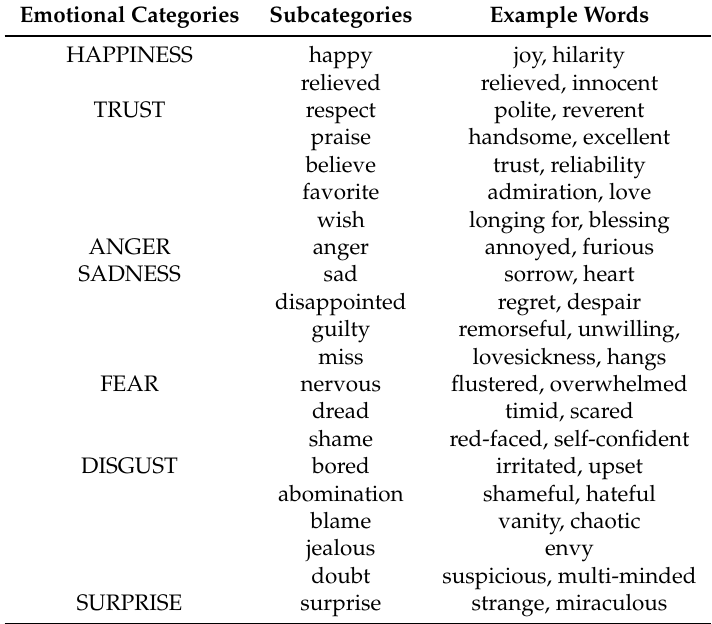
Table 3. Emotional